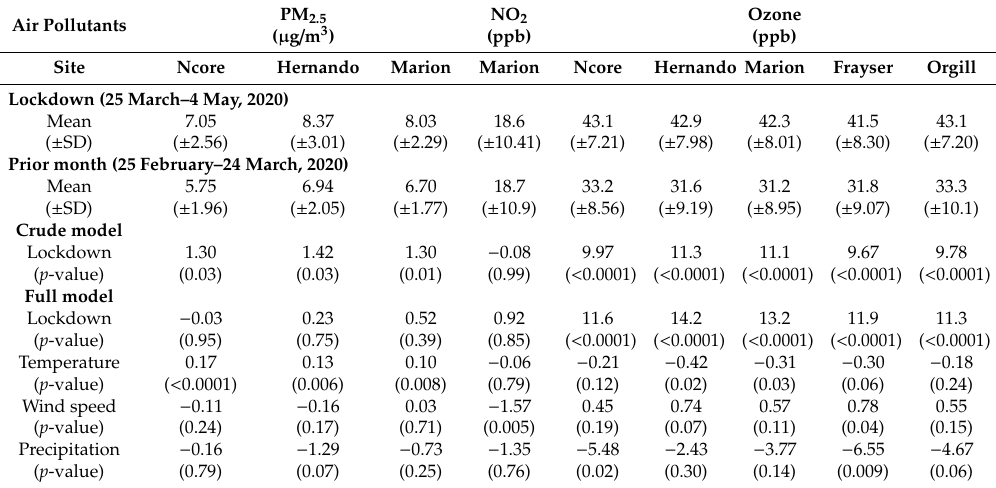
Figure 3. Comparison of average concentrations of PM 2.5 , NO 2 , and ozone in the Memphis Metropolitan Area between the lockdown period (25 March–4 May, 2020) and the prior month (25 February–24 March, 2020). The green lines indicate the annual national standards. The error bars indicate the standard deviations. Table 4. Comparisons of PM 2.5 , NO 2 , and ozone concentrations during the lockdown and prior month.